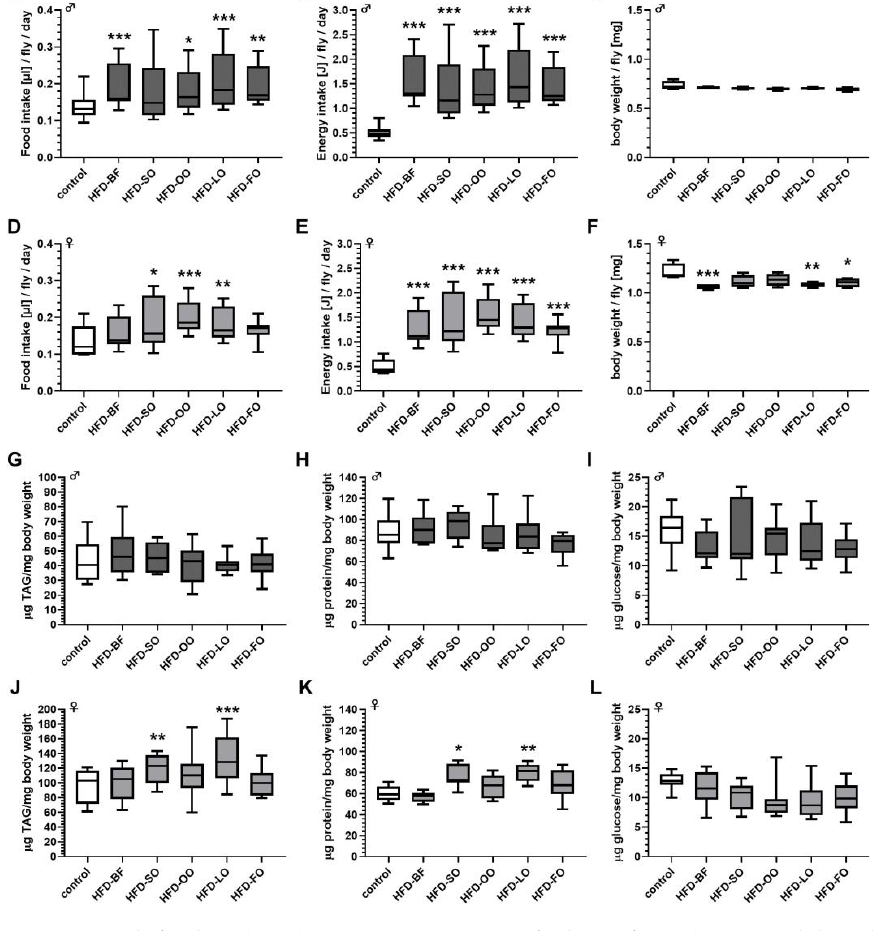
Figure 1. High-fat diets (HFD) comprising 3 – 12% ( w / v ) butterfat (BF) increased the calculated en- ergy intake without affecting body weight and body composition of male and female D. melanogaster . D. melanogaster w 1118 were fed ad libitum for 7 days on a standard sugar yeast control medium and on HFDs comprising increasing BF contents, respectively, before their food consumption and body composition were examined. ( A ) In males, the food intake was not affected up to 9% BF, how- ever, significantly increased on an HFD-12, ( D ) whereas female flies did not change their food con- sumption at any applied BF concentration ( n = 3 replicates; N = 225 flies per treatment in total). The corresponding energy content values for the ingested food, which were calculated for ( B ) male and ( E ) females indicate that, in both sexes, the energy content was dose-dependently and significantly increased by BF supplementation. The body weight and body composition (triacylglycerol (TAG), protein, glucose content) of male ( C , G – I ) and ( F , J – L ) female flies did not differ between the treat- ment groups (body weight: n = 3 replicates, N = 120 animals per treatment; body composition: n = 3 replicates; N = 18 flies per treatment). Data are shown as boxplots with whiskers indicating minimal and maximal values. Statistical significance was assumed at * p < 0.05, ** p < 0.01, *** p < 0.001 (ANOVA). (HFD-3: high-fat diet with 3% ( w / v ) BF, HFD-6: high-fat diet with 6% ( w / v ) BF, HFD-9: high-fat diet with 9% ( w / v ) BF, HFD-12: high-fat diet with 12% ( w / v ) BF). 3.2. Female Fecundity Decreased in a Dose-Dependent Manner in Response to Butterfat Supple- mentation We next examined whether the increasing energy intake of female fruit flies that were fed the BF-supplemented HFDs affects the reproduction. As shown in Figure 2A, dietary BF significantly reduced the number of eggs laid per female over a 15-day investigation